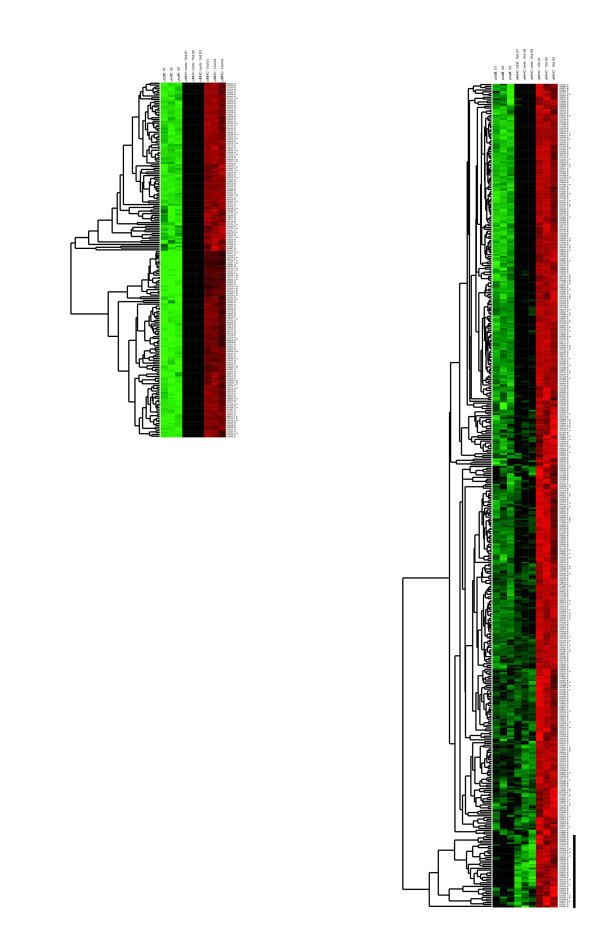
Hierarchical clustering of probe sets identified as upregulated in α-MHC+ cells. Shown is a visualization of the hierarchical clustering of probe sets identified as upregulated in the α-myosin heavy chain (MHC)+ cells with an expression level at least twofold higher than in 15-day-old EBs and in α-MHC embryonic stem cells. Each probe set is represented by a single row of colored boxes; each array is represented by a single column. Rectangles corresponding to intermediately expressed probe sets are colored black, upregulated probe sets are indicated with red of increasing intensity, and weakly expressed probe sets with green of increasing intensity. The dendrogram on the left of the figure represents the similarity matrix of probe sets.